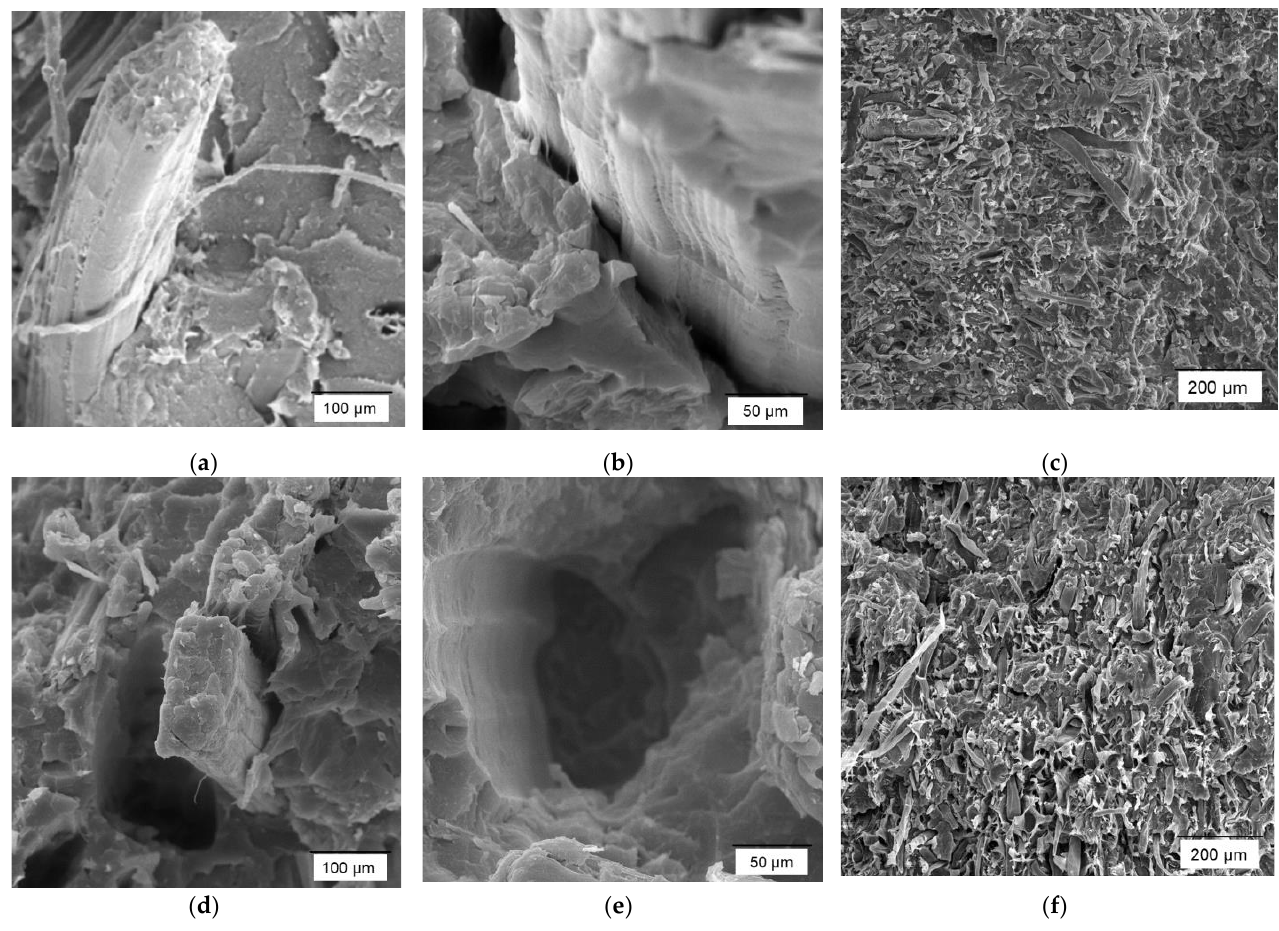
Figure 2. Composites reinforced with henequen fibers scanning electron microscopy images (SEM): ( a , b ) 30 wt.% henequen with MAPP; ( c ) 50 wt.% henequen with MAPP; ( d , e ) 30 wt.% henequen without MAPP; ( f ) 50 wt.% henequen without MAPP.